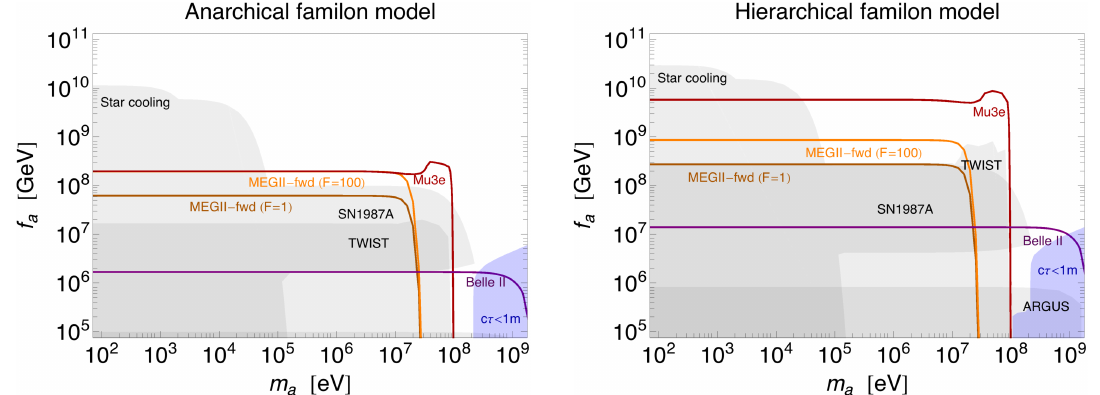
Figure 12 . Present bounds and future sensitivities on the decay constant f a (in GeV) vs. the mass m a for two familon models. The blue shaded regions indicate where the familon decays promptly into SM states. The grey shaded regions are currently excluded by a combination of µ + → e + a experiments and star cooling bounds on the ALP-electron coupling. We show projected sensitivities of MEGII-fwd in orange , Mu3e in red , Belle II in purple . Left: Anarchical model, cf. eq. (7.41), Right: Hierarchical model, cf. eq.